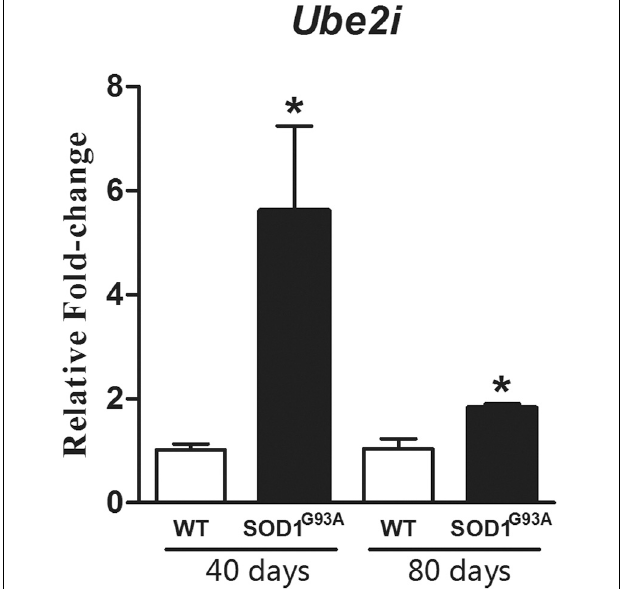
FIGURE 3 | Graph shows relative fold change values for Ube2i in microdissected astrocytes from 40 and 80 days old SOD1 G93A mice compared to the age matched wild-type controls (WT). Significant increases are seen in both transgenic astrocytes enriched samples. Results are presented as means ± s.e.m. from 3 samples used for each group. ∗ p -value < 0.05, according to unpaired t